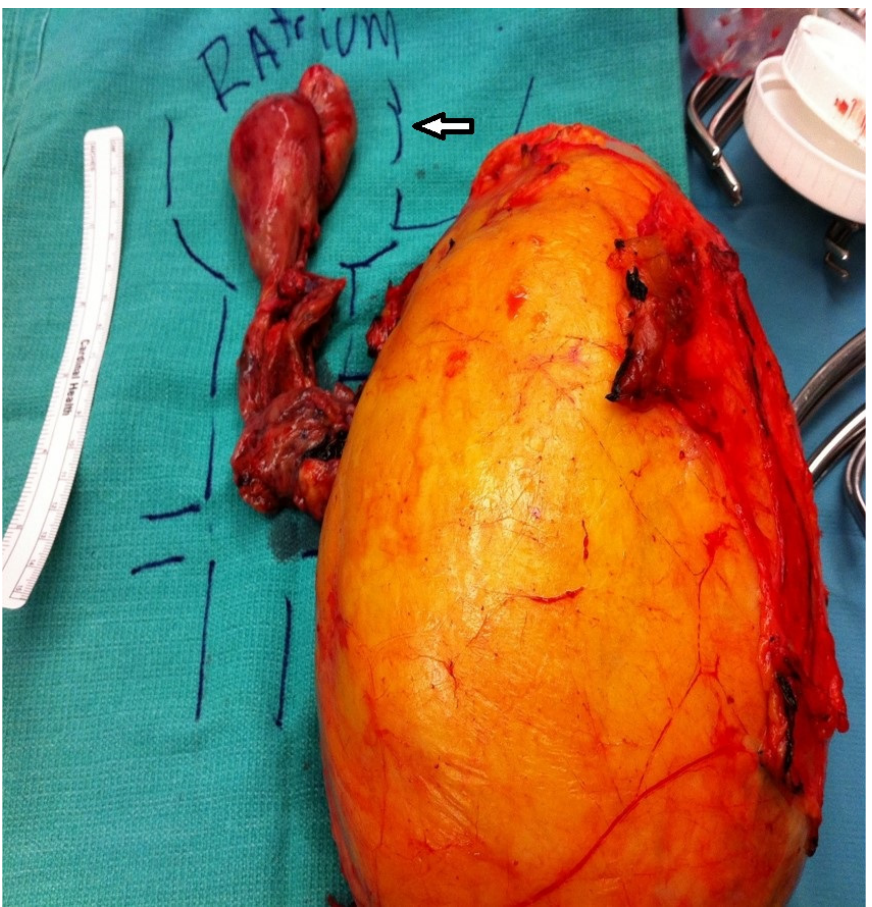
Figure 2. Surgical specimen of a large left renal cell carcinoma with a large tumor thrombus extending into the right atrium (white arrow).